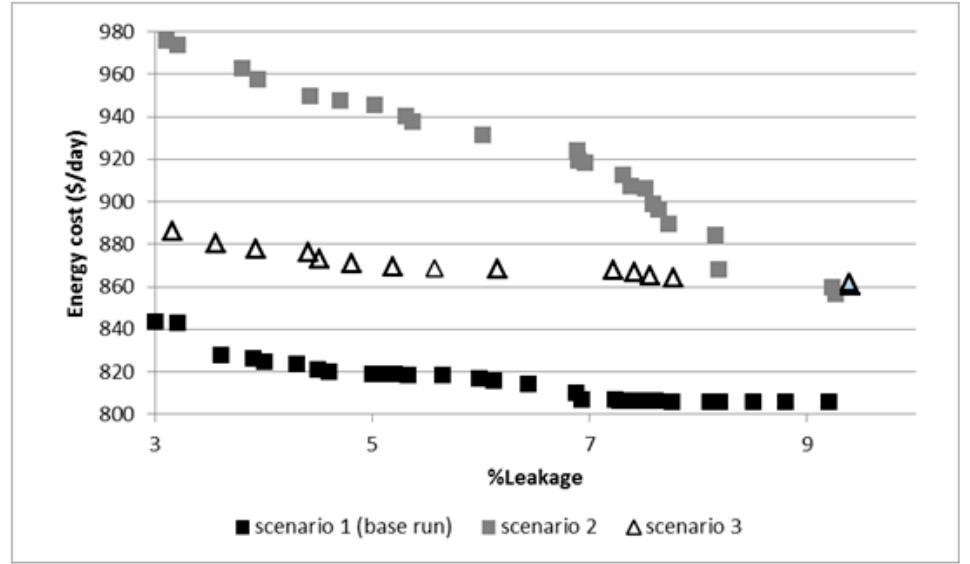
Figure 11. Solutions for different electricity tariffs in net 3-b.